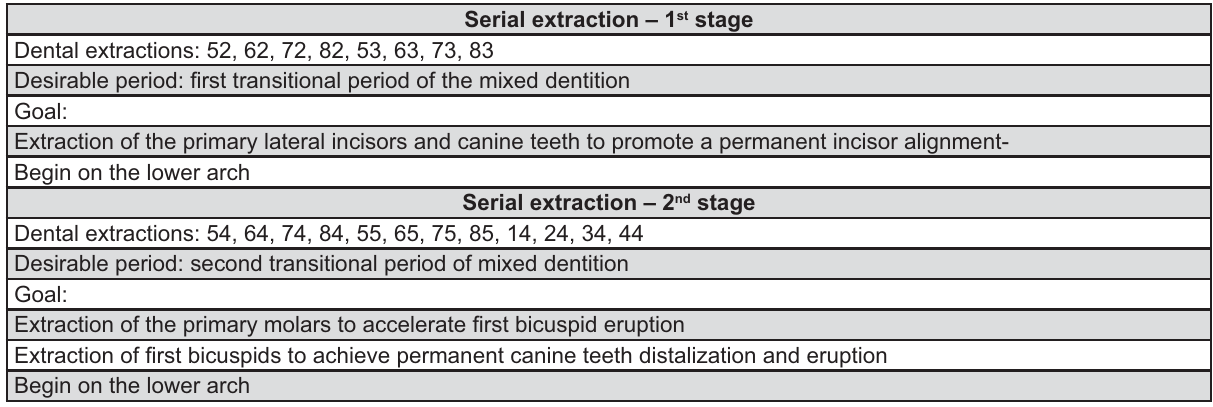
Figure 1- Operative phases of the serial extraction program